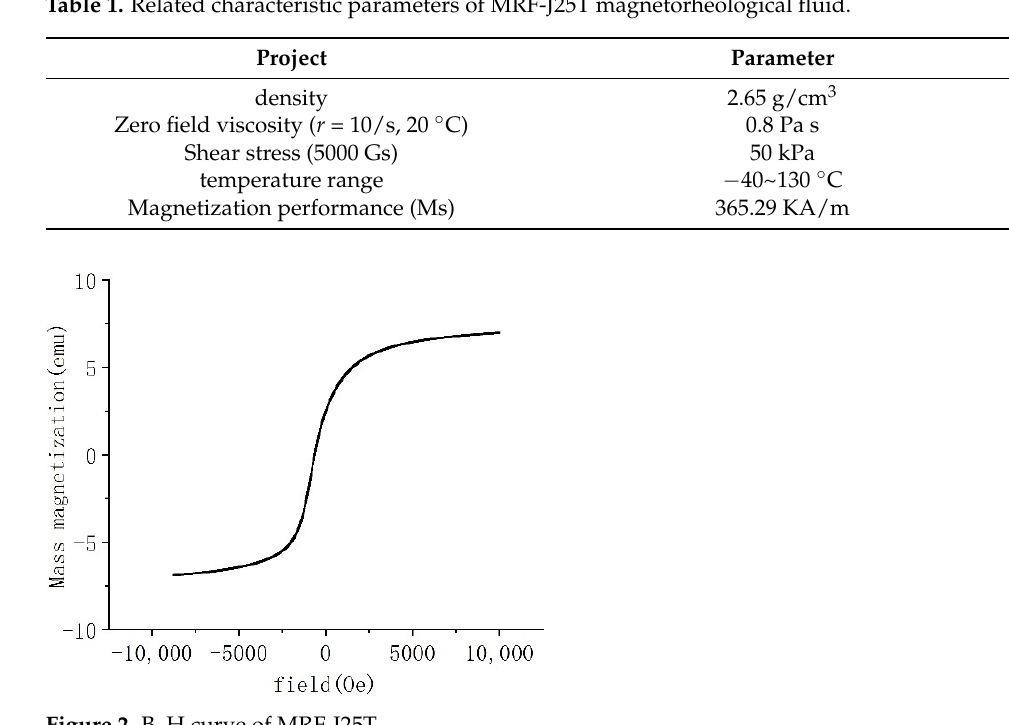
Table 1. Related characteristic parameters of MRF-J25T magnetorheological fluid.